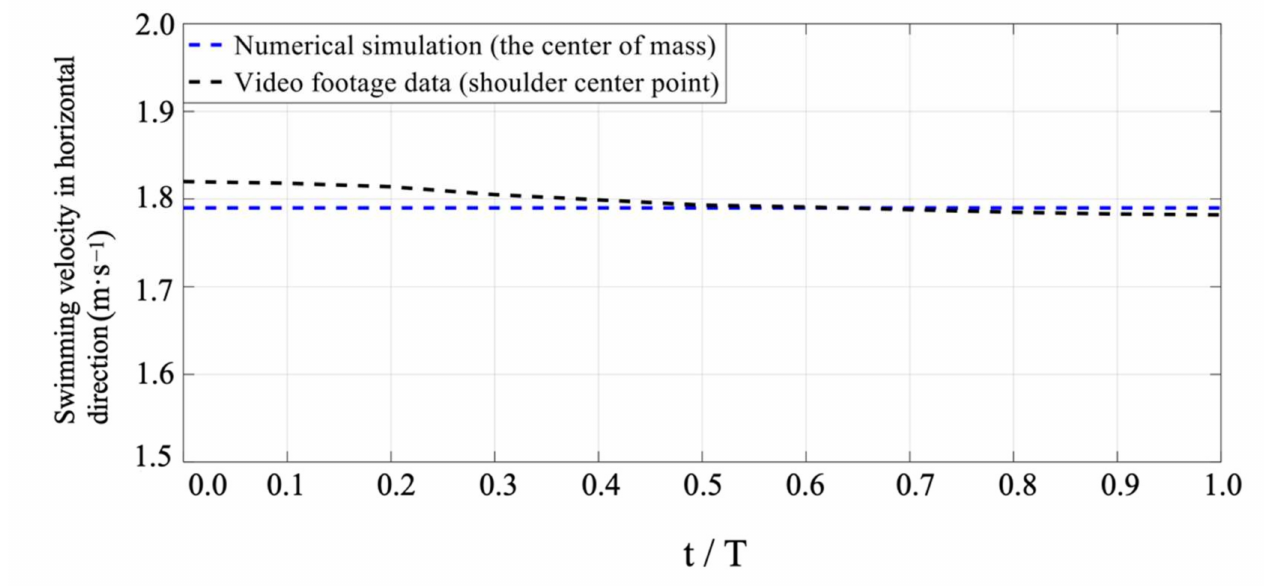
Figure 5. The frontal position of the swimmer alongside the corresponding frame of the video footage. ( a , b ) corresponds to the flexion kick of the UUS; ( c , d ) corresponds to the extension kick of the UUS.